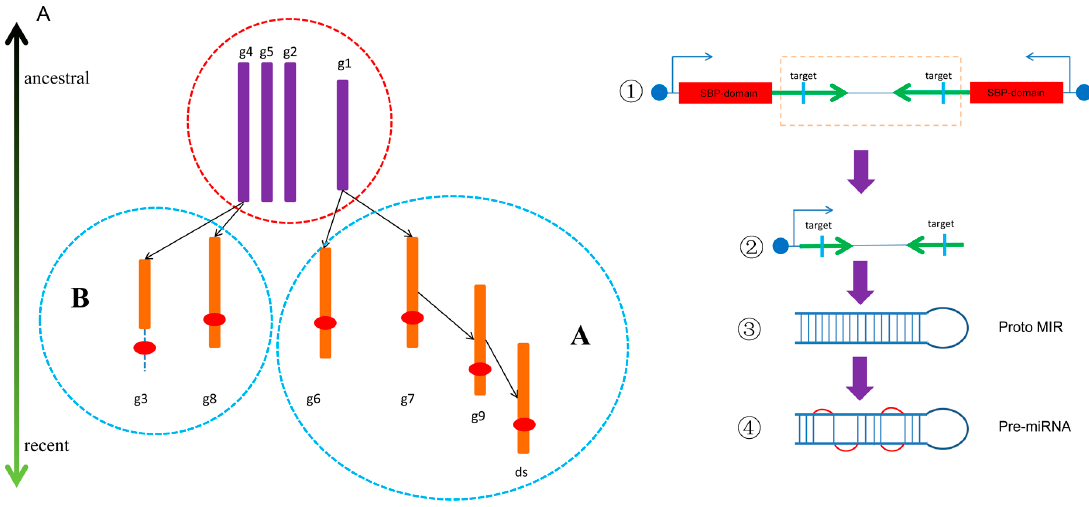
Figure 8. A derivation graph of the dynamic evolutionary process of SBP genes in flowering plants and the presumed model of the emergence of miR156. ( A ) A derivation graph of the dynamic evolutionary process of SBP genes in flowering plants. The terrestrial plant conservative groups are circled with a red dotted line. Angiosperm-specific groups associated with a terrestrial group relate to solid arrows, and the direction of the arrow represents the direction of evolution. Line A and Line B are circled by a blue dotted line, respectively. The red ovals refer to miR156 target sequences and the 3 (cid:48) UTR region is marked with a dotted line. ( B ) The presumed model of the emergence of miR156. 1 (cid:79) The emergence of the face-to-face tandem duplication of two SBP genes. 2 (cid:79) The formation of genes containing the ancestor sequence of MIR156 and MIR156*. 3 (cid:79) The formation of proto MIR156. 4 (cid:79) The formation of